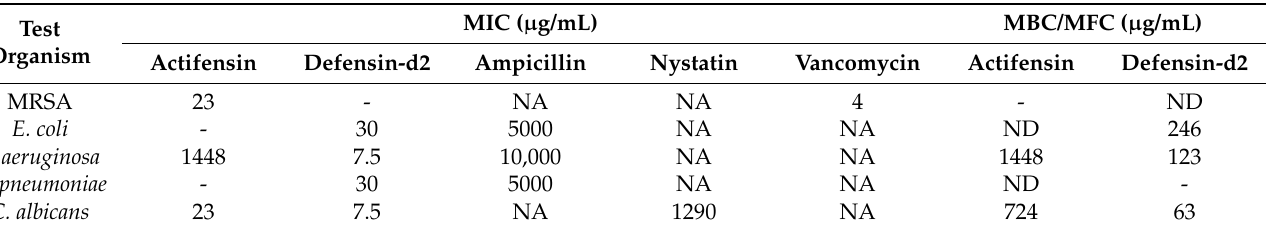
Table 3. Synergistic activity of recombinant